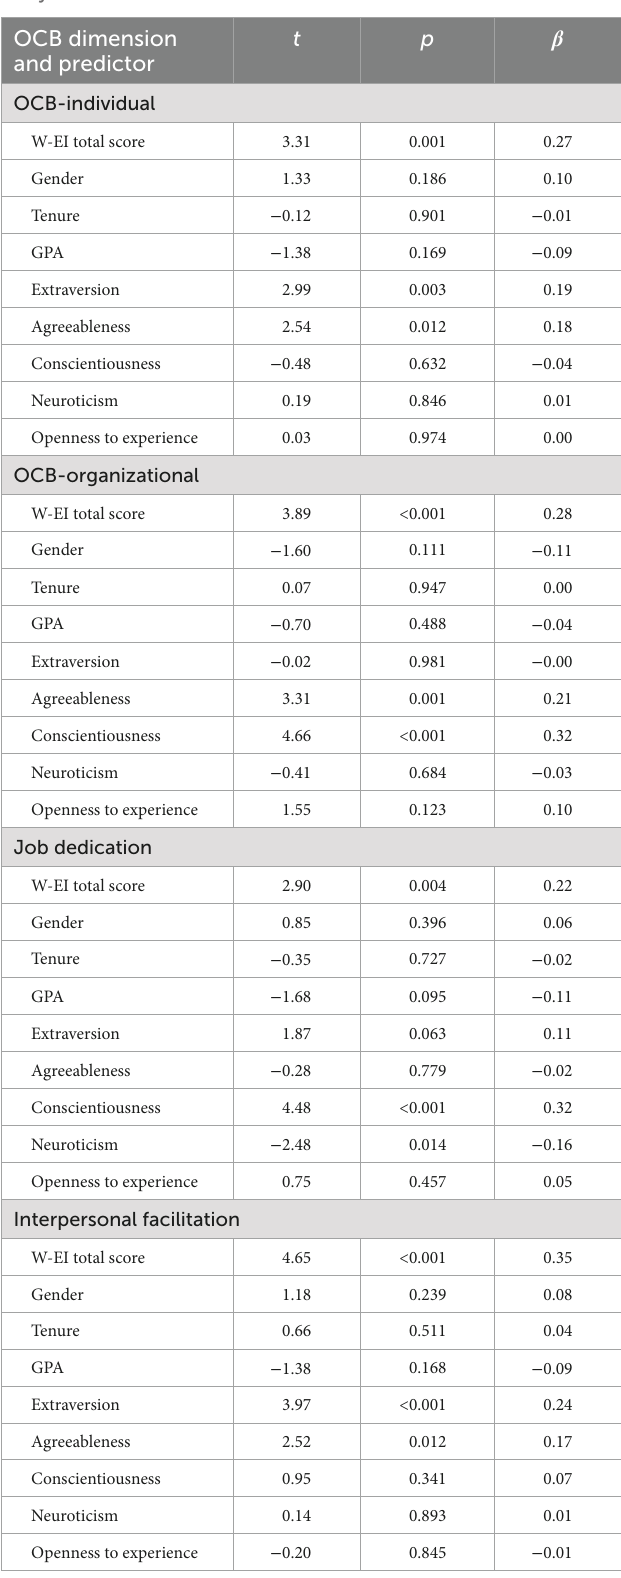
TABLE 4 Work-related emotional intelligence (W-EI) as a predictor of organizational citizenship behavior (OCB), multiple regression results, Study